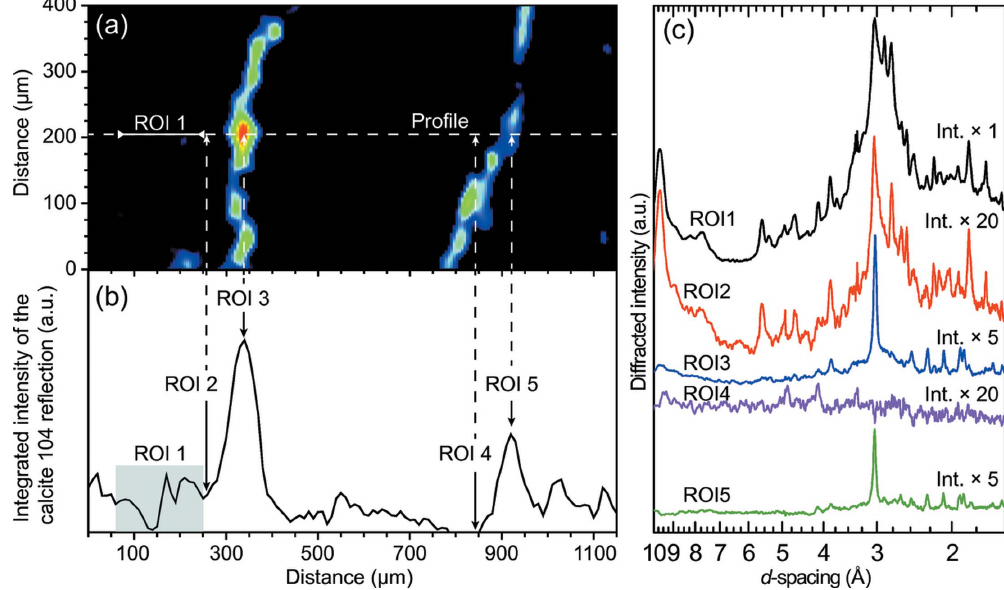
Figure 5 ( a ) Mapping of the integrated intensity of the calcite 104 reflection. The area is the same as the central part of the porosity shown in Fig. 4, slice z 0 . The white dashed line represents the profile along which the calcite 104 reflection has been integrated [see panel ( b )]. ( c ) The XRD patterns reconstructed for the five regions of interest (ROI) identified in panel ( b ) are plotted. Note that the XRD patterns collected in ROIs 3 and 5 are pure calcite (see Fig. 3). The width of the ROI is 1 pixel (10 m m), with the exception of ROI 1 which is larger. The number after Int. (cid:2) indicates the multiplication factor used to scale the intensity in the